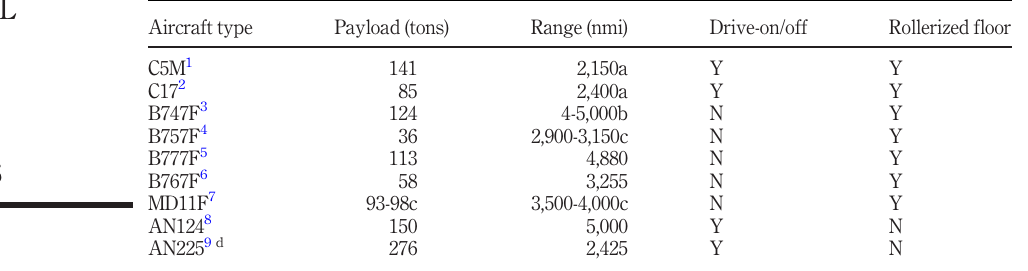
Table I. Comparison of